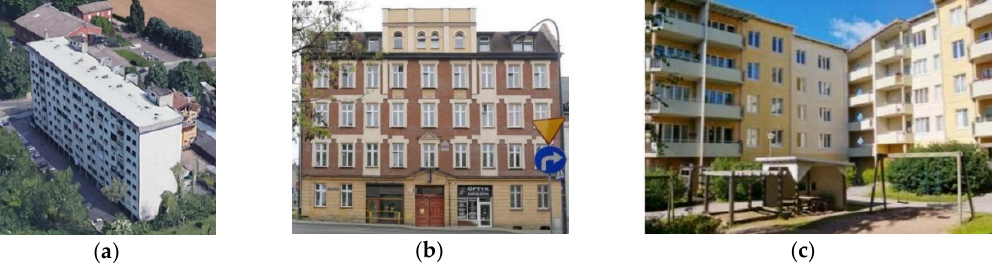
Figure 6. Demonstration sites chosen for the validation of the BIM4EEB developed tools. ( a ) Italian pilot site; ( b ) Polish pilot site; ( c ) Finnish pilot site. All photos are taken from the Grant Agreement of BIM4EEB project.